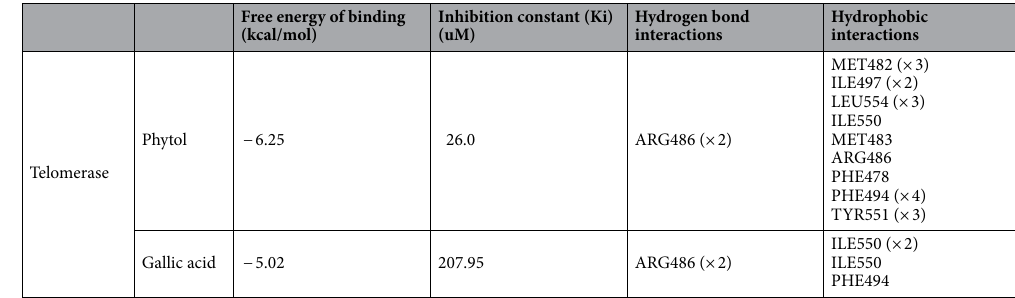
Free energy of binding